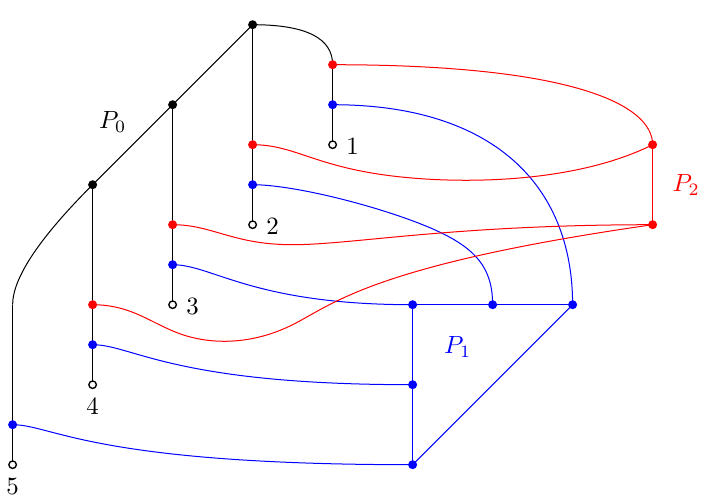
Figure 13: The canonical network N works P = ( P